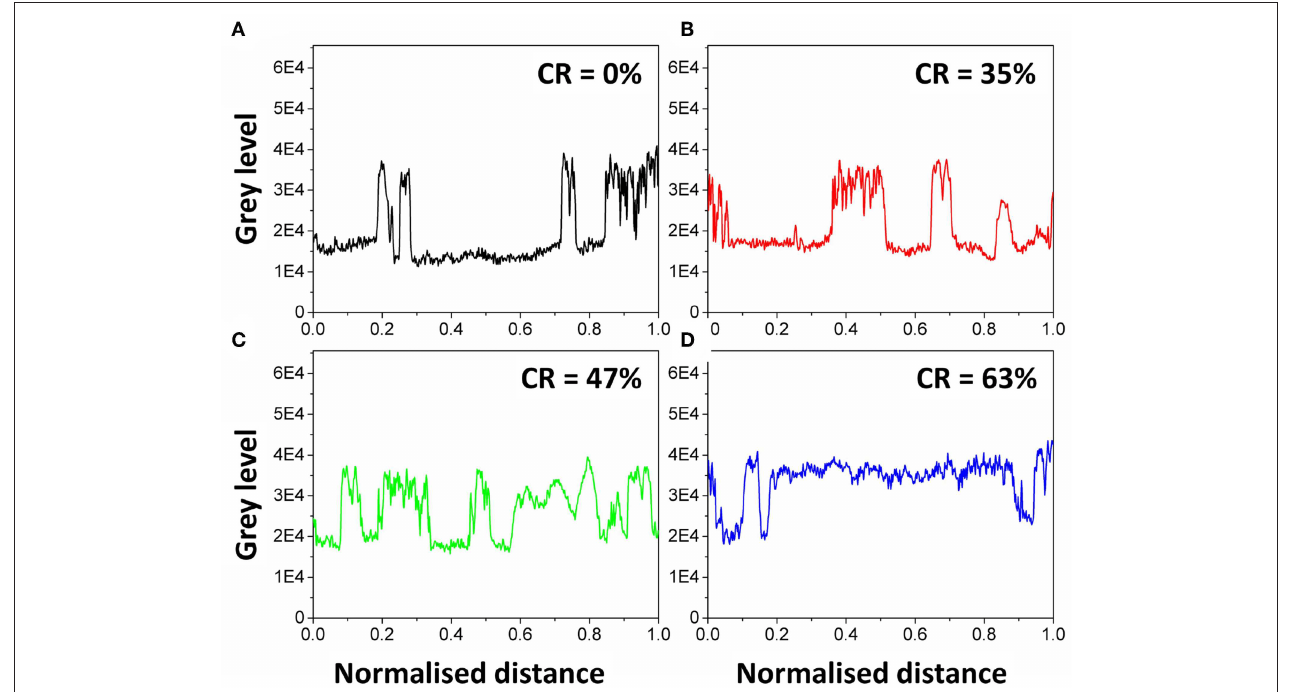
FIGURE 5 | Gray levels variation along the dashed lines indicated respectively in Figures 4A–D . (A–D) Correspond respectively to the compaction ratios of 0; 35; 47 and 63%.